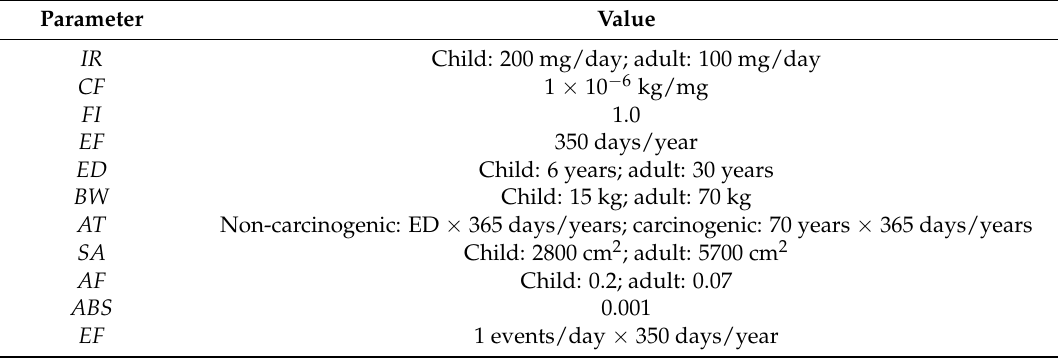
Table 2. The values of parameters used to estimate chronic daily intake ( CDI